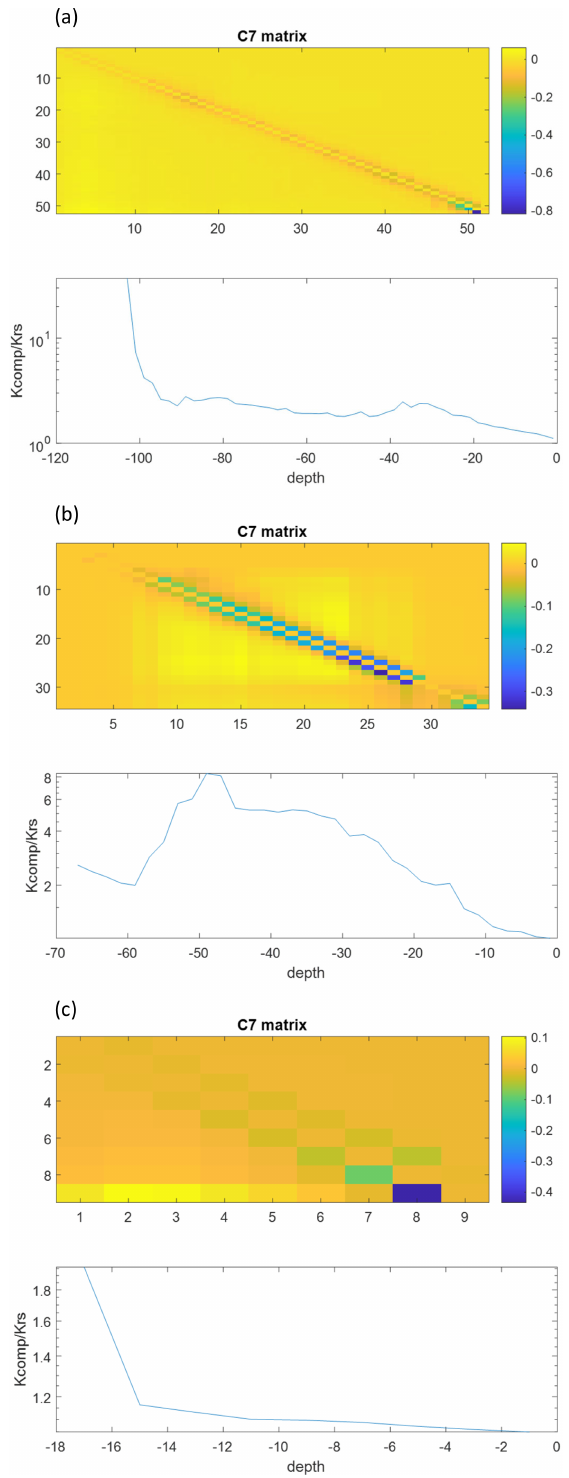
Figure 11. C 7 matrices and ratios of K comp /K rs of the exact model for the maize (a) , sunflower (b) , and grass (c) root